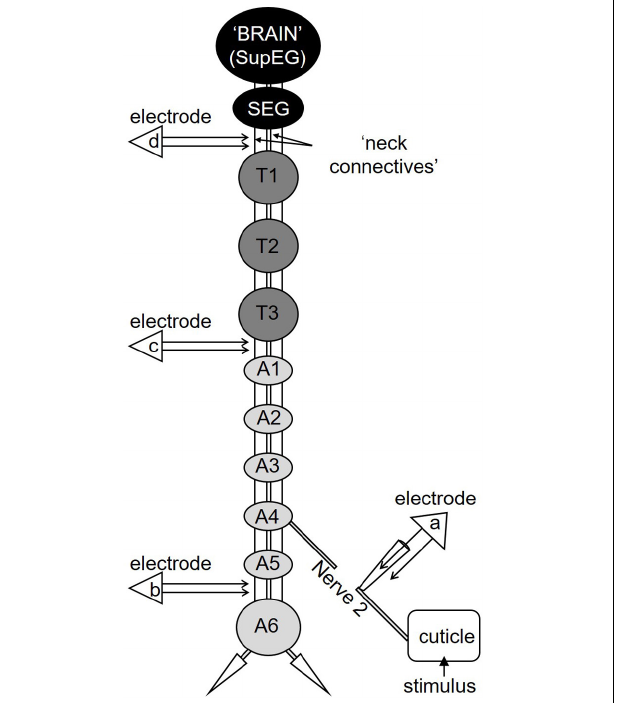
FIGURE 1 | A diagram depicting the cockroach’s nervous system. The cockroach’s nervous system comprises two head ganglia (the SupEG or “Brain” and the SEG; black) three thoracic ganglia (T1–T3; dark gray) and six abdominal ganglia (A1–A6; light gray). Two connectives link between adjacent ganglia. The connectives between the head and thorax are termed “neck connectives.” One example of the peripheral Nerve 2 is illustrated on one side of the abdominal ganglion A4. In this preparation Nerve 2 is severed and suction electrode “a” is positioned so the recording is of the sensory input from the cuticle only. Electrodes “b,” “c,” and “d” are shown in the appropriate location along the nervous system and are placed on a single